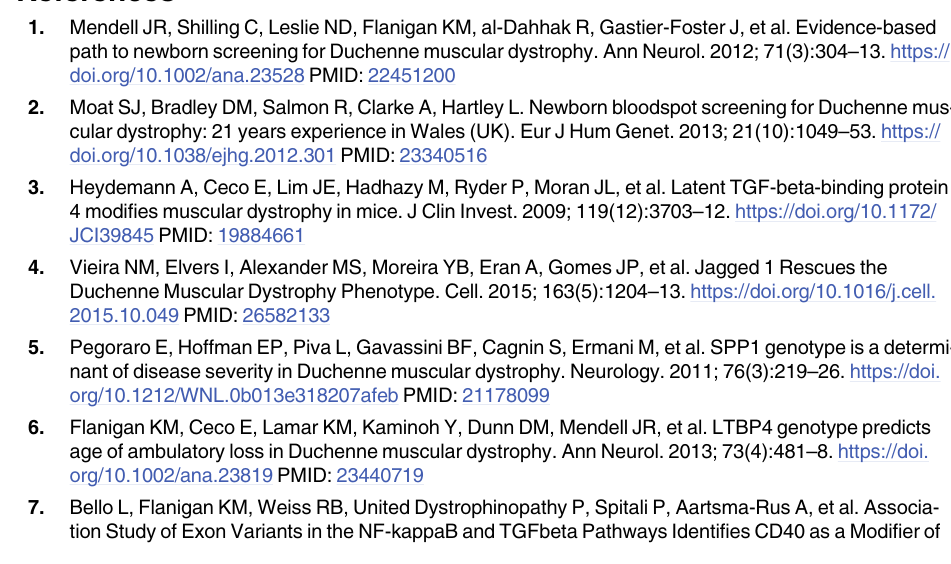
S1 Fig. The figure below shows the fit of the Weibull distribution to the Kaplan-Meier curves for the simulated data under Model 1 (non-mixture model), based on all 1,000 replicates of N = 500 individuals each, for (A) y = 0 and (B) y =